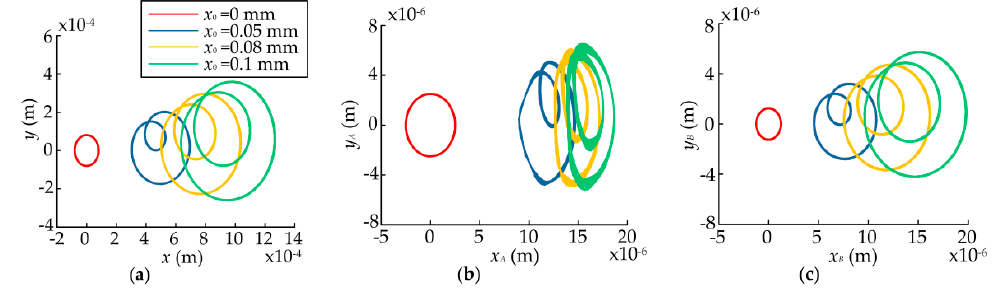
Figure 6. Rotor shaft orbits and bearing shaft orbits for different eccentricities. ( a ) Rotor shaft orbits; ( b ) Left-bearing shaft orbits; ( c ) Right-bearing shaft orbits.